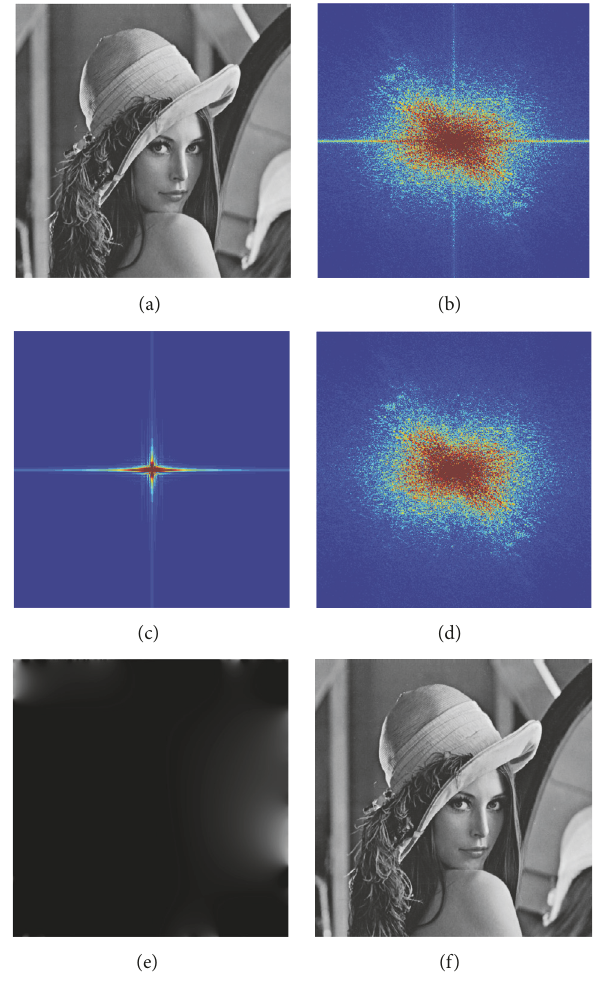
Figure 3: (1a) An image with nonperiodic boundary. (1b) 2D DFT of (1a). (1c) DFT of the smooth component, i.e., the removed artifacts from (1a). (1d) Periodic component, i.e., DFT of (1a) with edge artifacts removed. (1e) Reconstructed smooth component. (1f) Reconstructed periodic